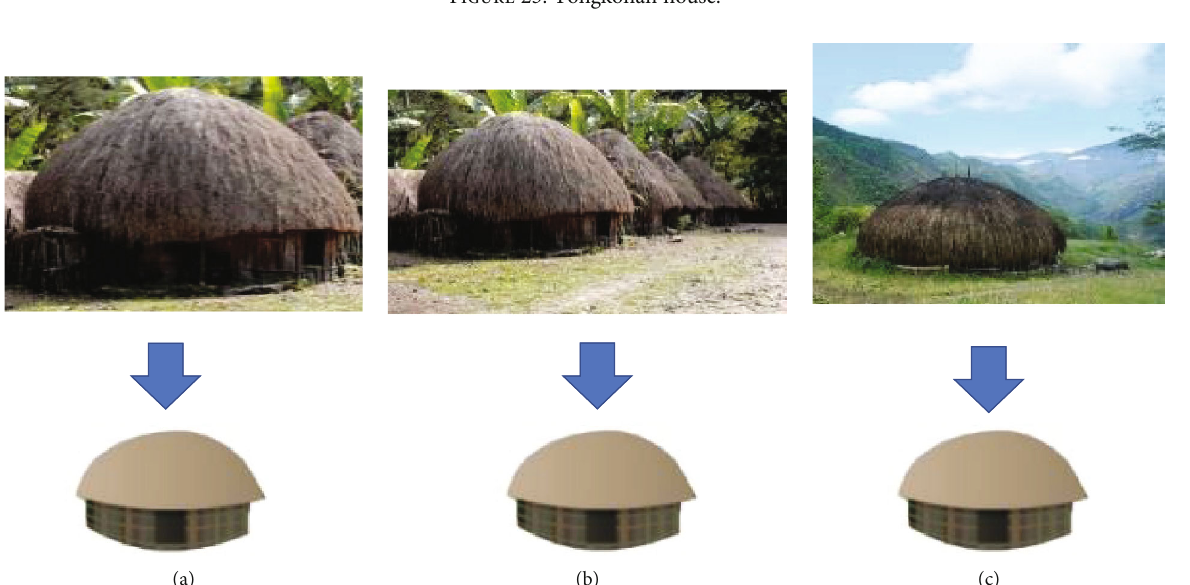
Figure 26: Hanoi